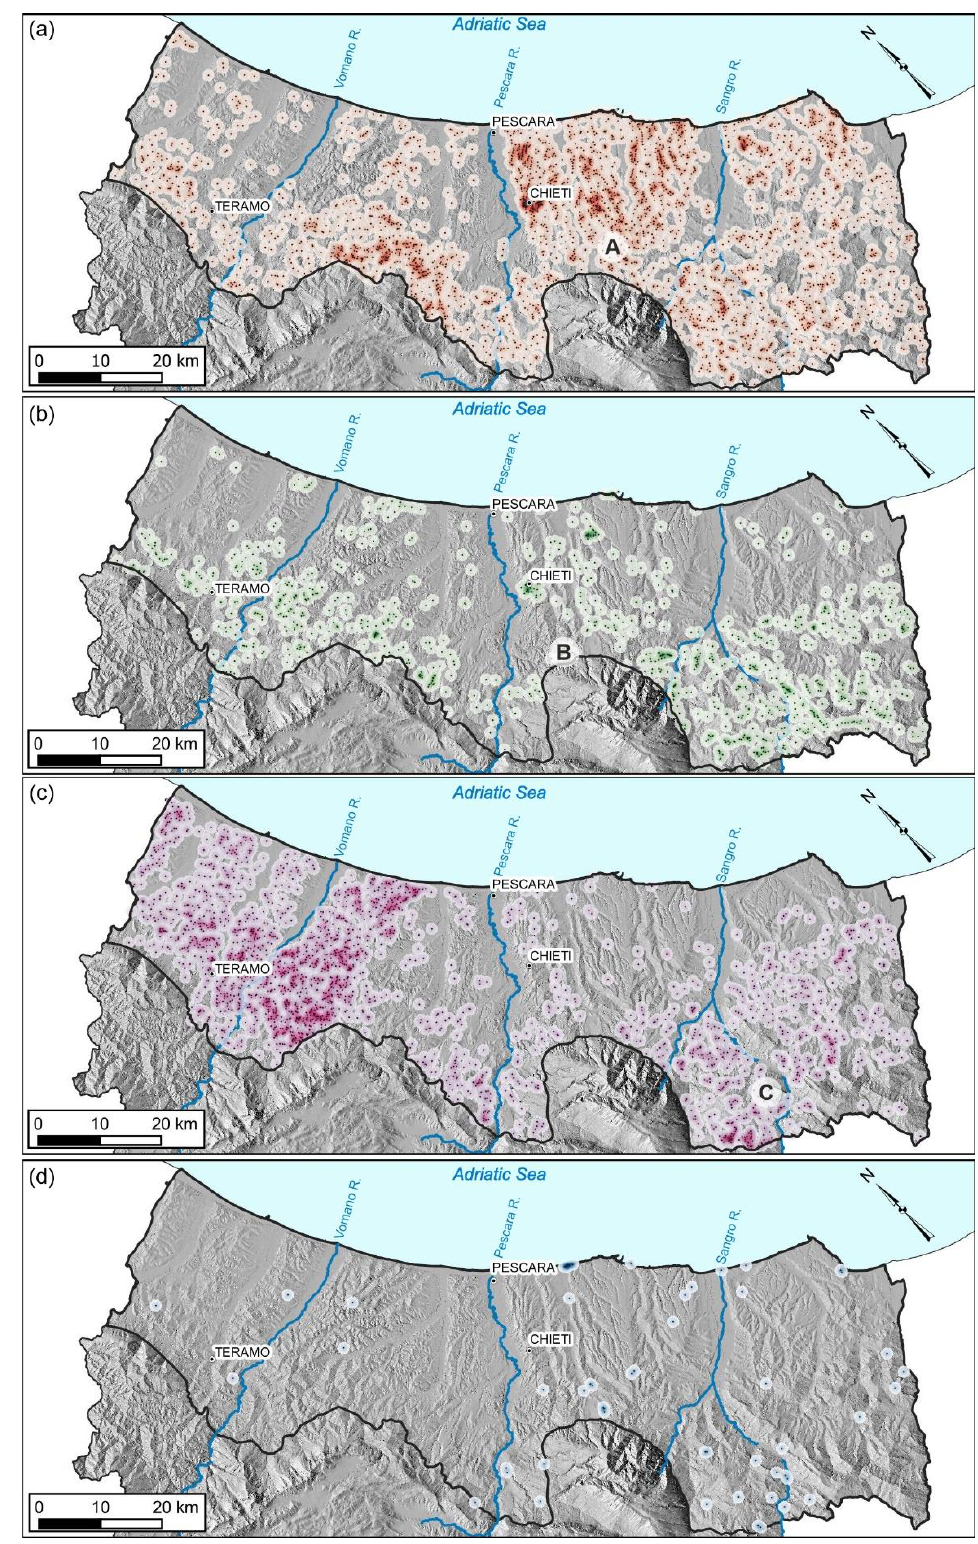
Figure 3. Density maps (heatmaps) of various slope instability processes over the Abruzzo hilly piedmont area: ( a ) rotational and translational slides; ( b ) complex landslides; ( c ) earth flows; ( d ) rockfalls. Colored areas represent the sites with a higher density of slope instability processes in each category (black dots). Capital letters in white circles locate the selected case studies. The black line represents the study area.